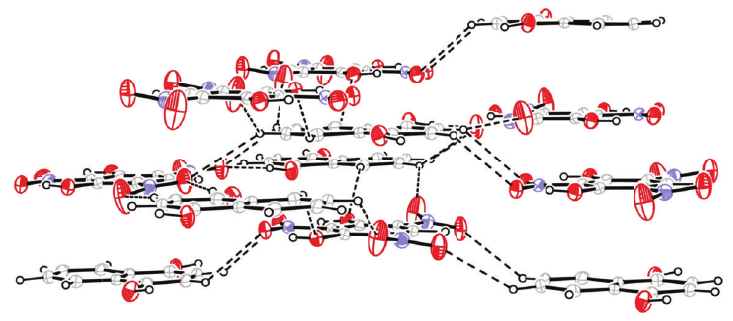
Figure 9: The view of bifurcated hydrogen bonds.